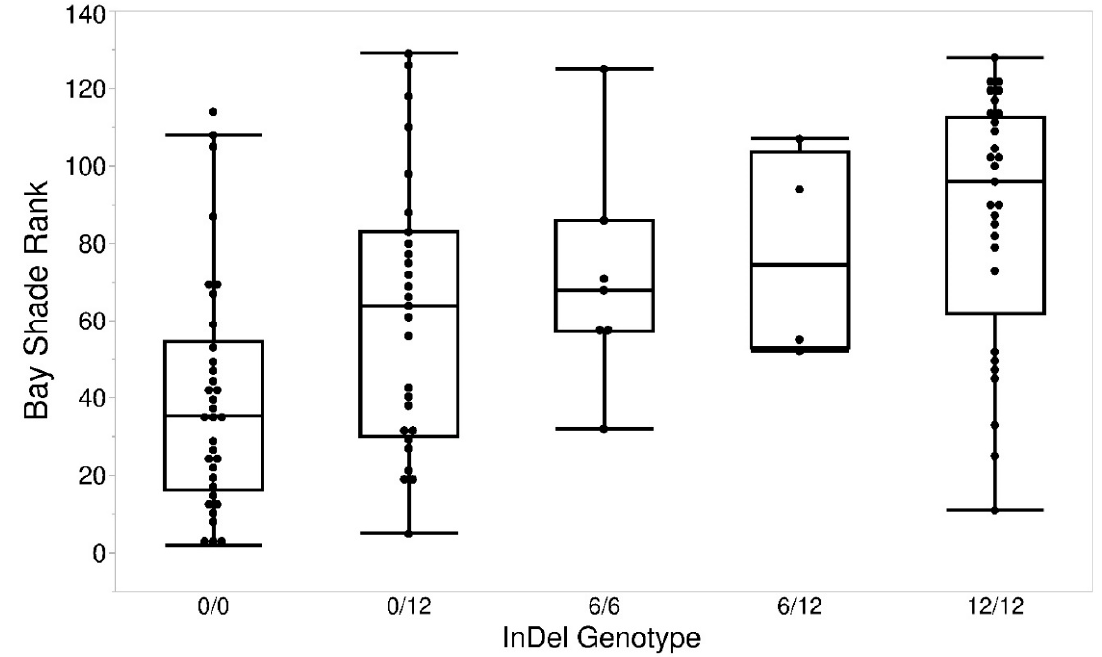
Figure 4. Shade of bay phenotype (rank) differs by genotypes at the RALY indel polymorphism. Median ranks for the genotypes, left to right, are as follows: 35.5, 64, 74.5, 68, and 96.